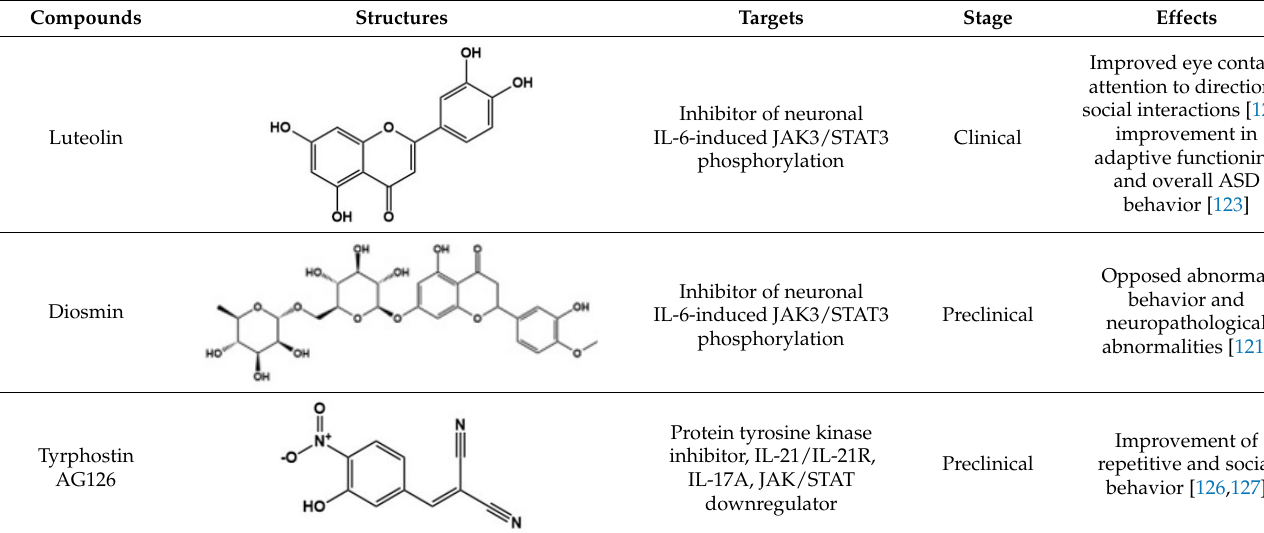
Table 3. Immune regulation agents and their potential effects on treating ASD symptoms. IL: interleukin, JAK/STAT: janus tyrosine kinase/signal transducer and activator of transcription, IFN: interferon, TNF: tumor necrosis factor.